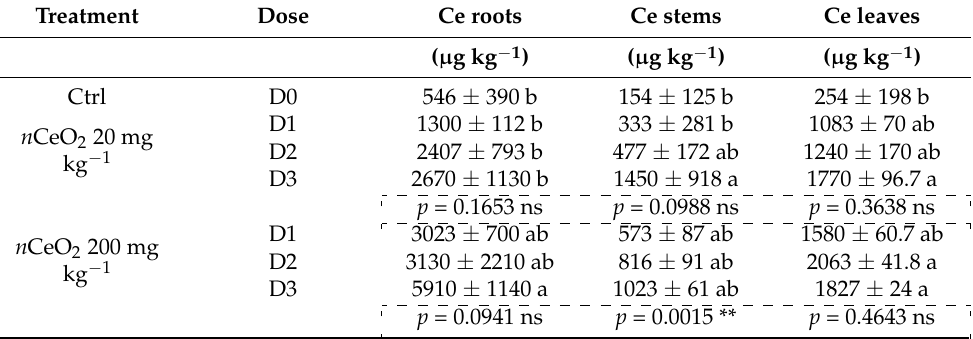
Table 2. Ce concentration in plant fraction and Ce translocation factor in S. flos cuculi grown in the presence of different inputs of n CeO 2 (20 and 200 mg kg − 1 .) Data are mean ± standard deviation. Statistically significant differences ( p ≤ 0.05) are indicated by the letters using one-way ANOVA follow by Tukey’s test. Dashed boxes indicate ANOVA p -values ( p ≤ 0.05) within n CeO 2 concentration. ns: not significant at p ≤ 0.05; ** significant at p ≤